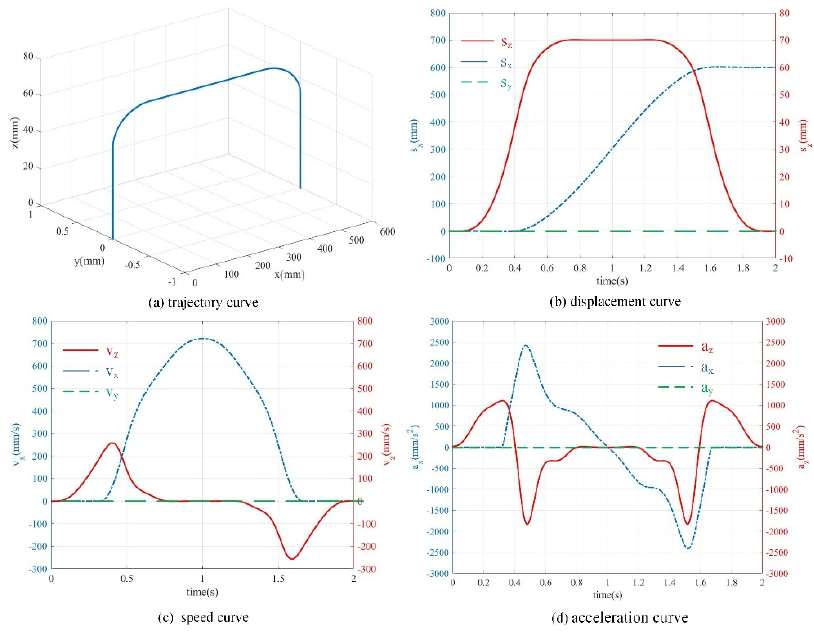
Figure 10. The motion parameter curves of the execution end.